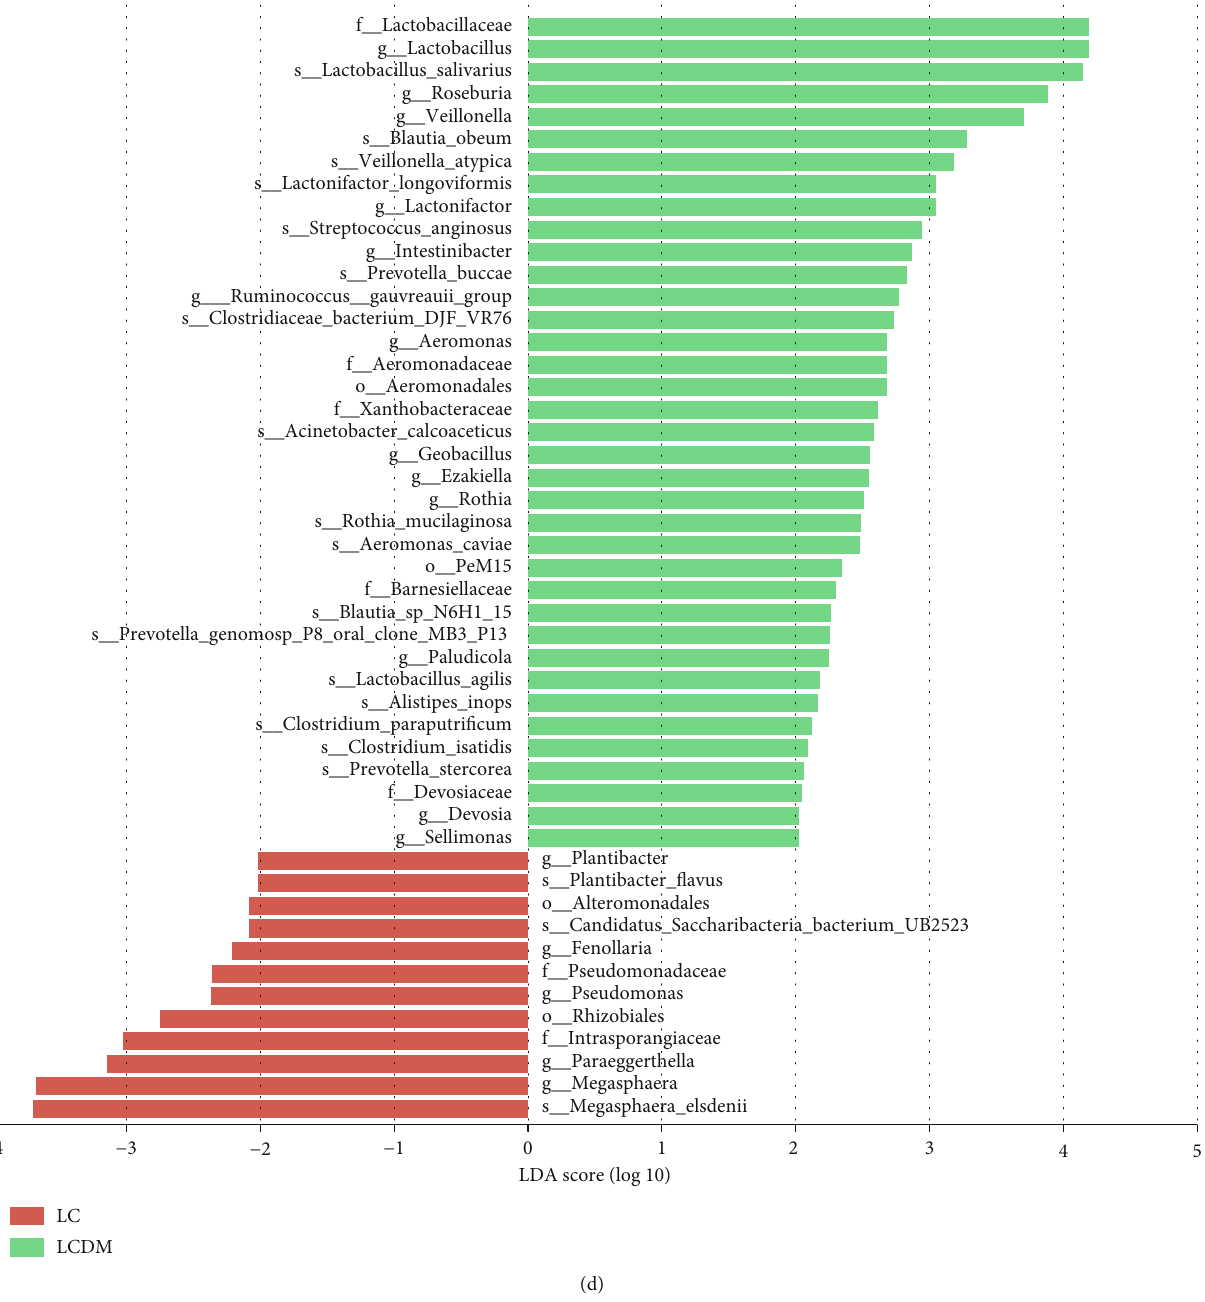
Figure 3: Characteristics of intestinal microbiota of HC, LC, and LCDM. The relative abundance of intestinal microbiota in HC, LC, and LCDM at the phylum (a) and genus level (b). (c) Di ff erential taxa identi fi ed by LEfSe analysis in HC and LCDM ( LDA > 4 : 0 ). (d) Di ff erential taxa identi fi ed by LEfSe analysis in LC and LCDM ( LDA > 2 : 0 ). HC: healthy controls; LC: HBV-related liver cirrhosis; LCDM: hepatitis B liver cirrhosis and diabetes